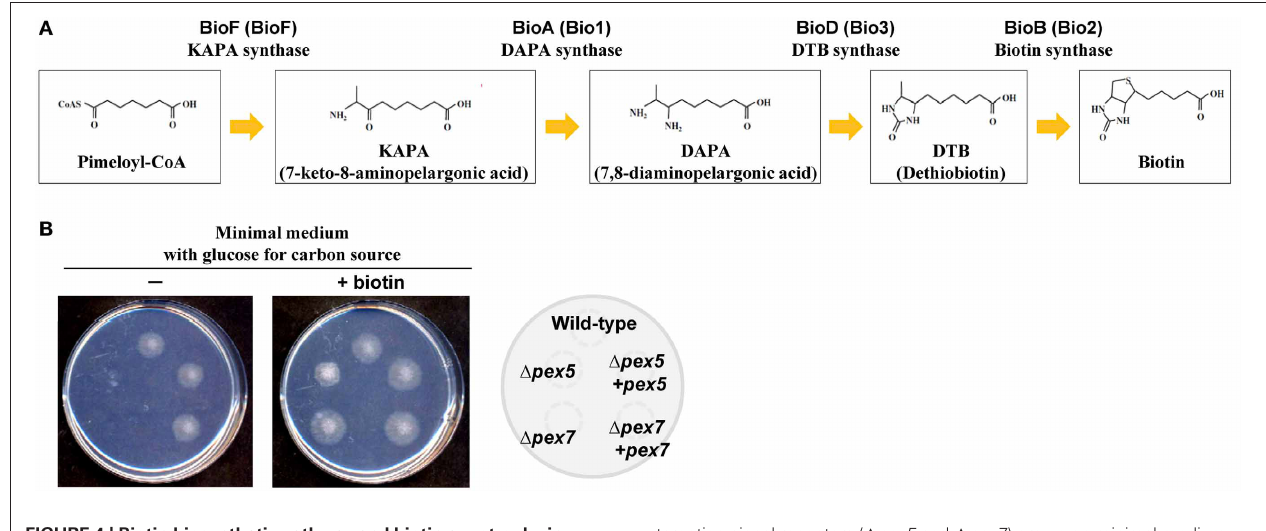
targeting signal receptors ( (cid:2) pex5 and (cid:2) pex7 ) grown on minimal medium containing glucose as the sole carbon source. Growth of the wild-type, (cid:2) pex5 , and (cid:2) pex7 strains and the complemented strains (indicated to the right) on medium with and without